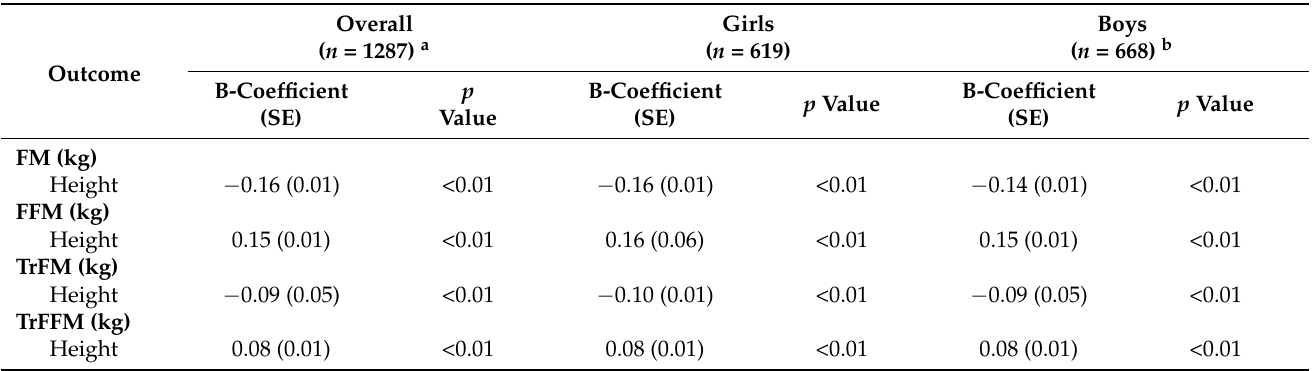
Table 2. Associations of overall and truncal body composition estimates with height among South African school-age children enrolled in the KaziAfya project.